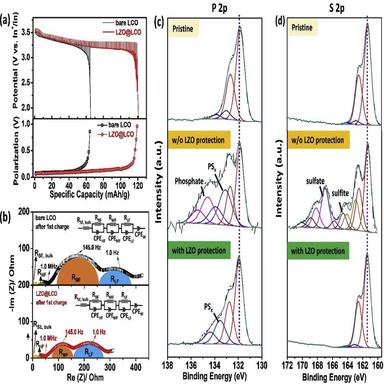
(a) Comparisons of the transient discharge voltage profiles and their corresponding polarization plots obtained by GITT, and (b) EIS analysis results for In// LPSCl//LZO@LCO/LPSCl and In//LPSCl//LCO/LPSCl full batteries; (c and d) XPS spectra of the P 2p and S 2p before and after battery cycling with and w/o LZO protections on the LCO cathode particles.